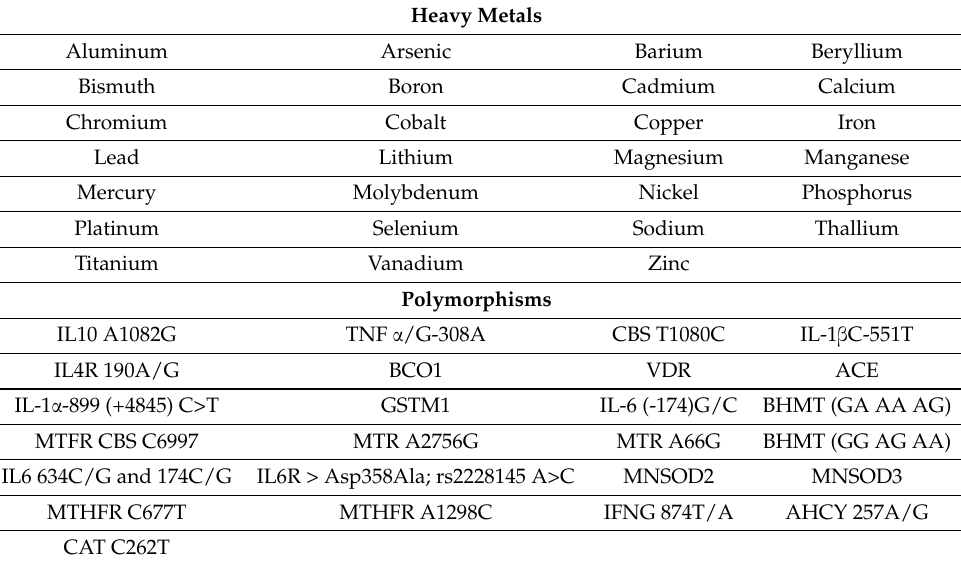
Table 1. List of analysed heavy metals and selected SNPs used as features in our analysis. The heavy metal concentrations are extracted by means of TMA hair tests.